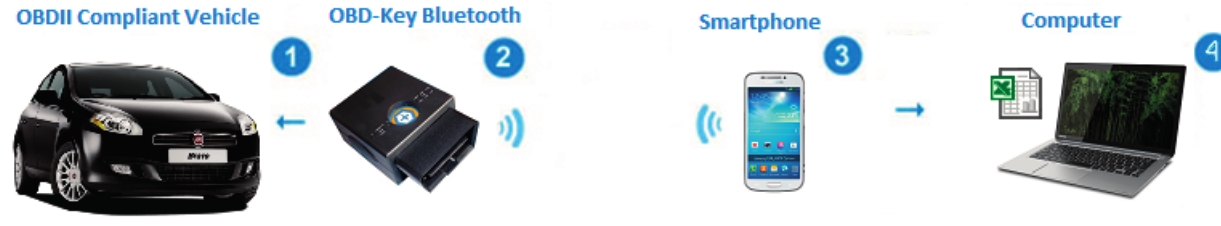
Figure 2. Data collection process.